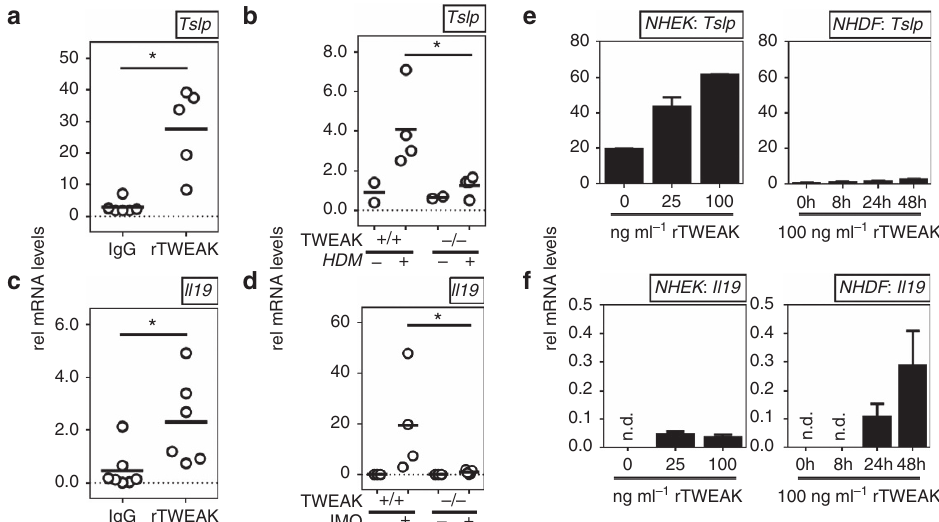
Figure 6 | TWEAK promotes cytokines associated with AD and psoriasis. ( a , c ) Naive WTmice were injected with rTWEAK or IgG administered once s.c. After 4 days expression of mRNA for TSLP and IL-19 was measured in skin biopsies. Data relative to GAPDH. Combined results from two experiments. ( b , d ) WTand TWEAK-deficient animals were treated with HDM for 4 days ( b ) or IMQ for 8 days ( d ) and mRNA for TSLP and IL-19, respectively, assessed in skin, relative to GAPDH expression. One out of three experiments shown. ( e , f ) NHEK cells (left) or NHDF cells (right) were stimulated for 48h or the indicated times with rTWEAK. mRNA expression of TSLP ( e ) and IL-19 ( f ) was assessed relative to GAPDH. Each data point in a – d represents one mouse. Bars represent mean values. The Mann–Whitney U -test was performed to compare the groups. Bars in ( e , f ) indicate mean values of triplicates and s.d. Values were compared using Student’s t- test. One out of three independent experiments. Asterisks indicate P o 0.05.